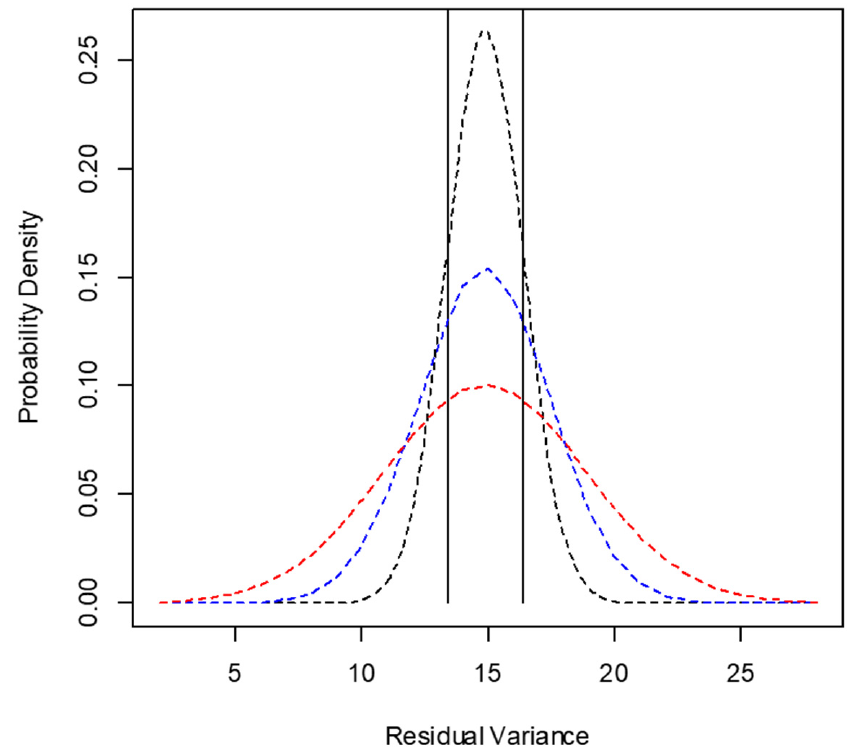
Figure 5. Example of probability distribution according to the central limit theorem for the residual variance of cottonseed meal DM degradation according to the number of animals used in the in situ trial [dashed lines: black = 4 animals; blue = 3 animals; red = 2 animals; the vertical lines delimit the